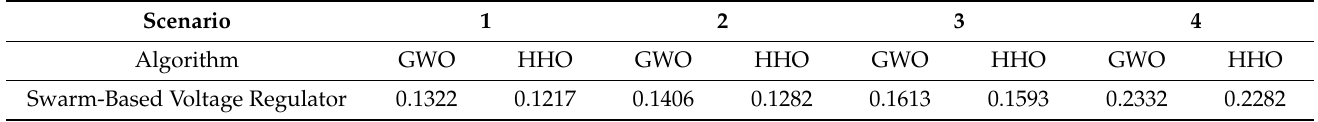
Table 4. MAPEs obtained by GWO and the HHO algorithms over ten runs of Figure